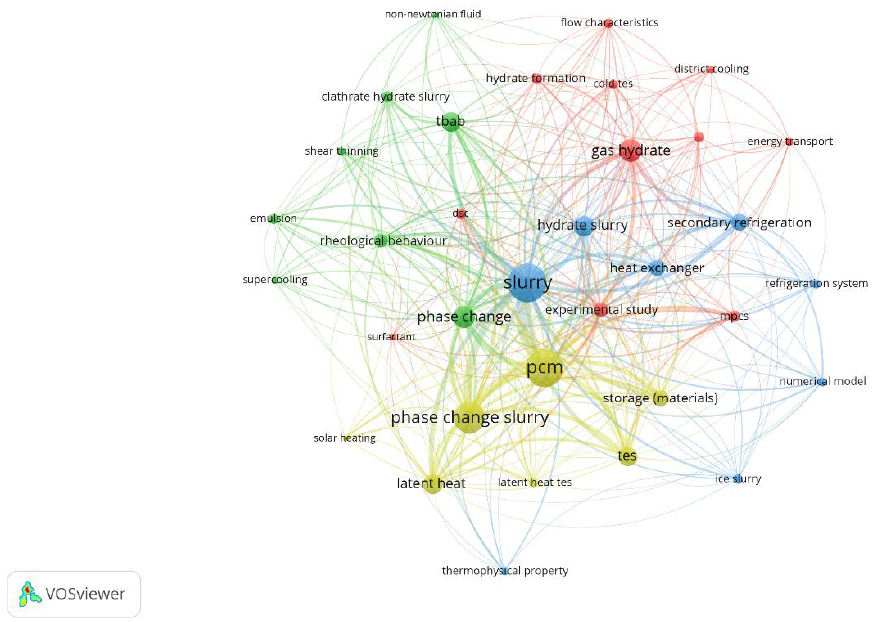
Figure 6. Co-occurrence of keywords made with the software VOSviewer.